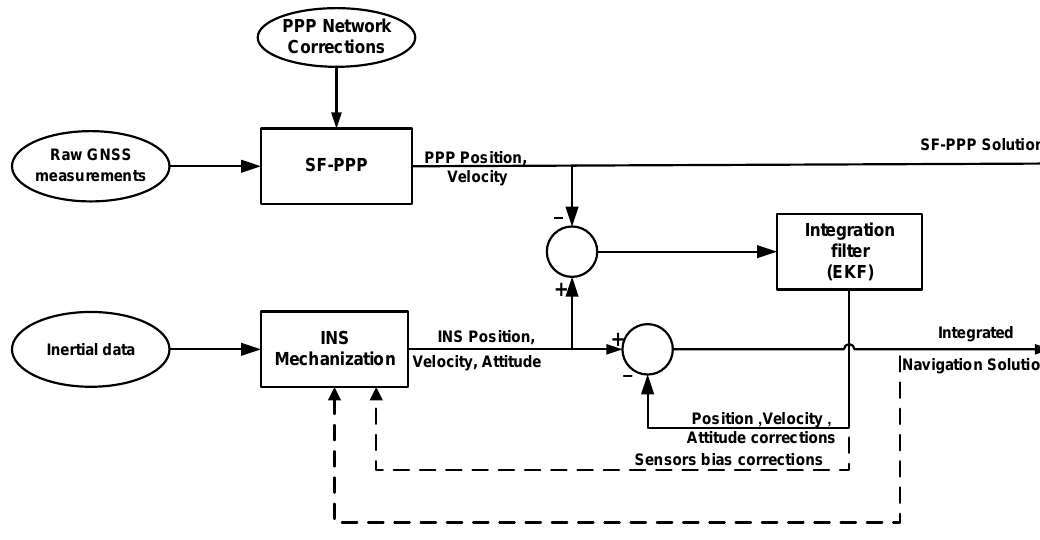
Figure 1. Block diagram of the developed SF-PPP/INS integrated system. The integration is performed in the loosely-coupled mode where the SF-PPP and INS solutions are integrated through an Extended Kalman filter. The dotted lines represent the closed-loop configuration where the estimated errors are fed back to the INS mechanization